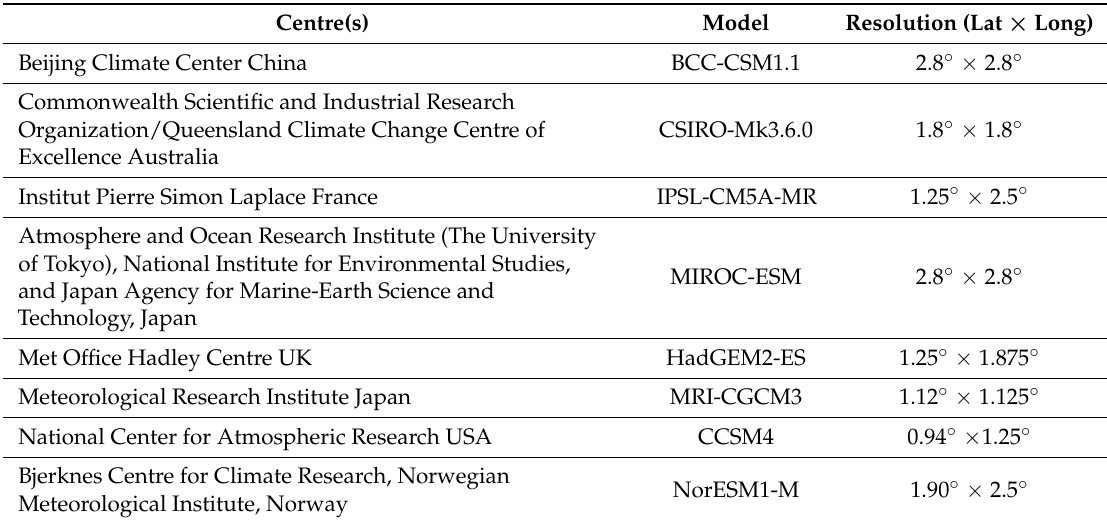
Table 1. List of IPCC CMIP5 GCMs used in the present